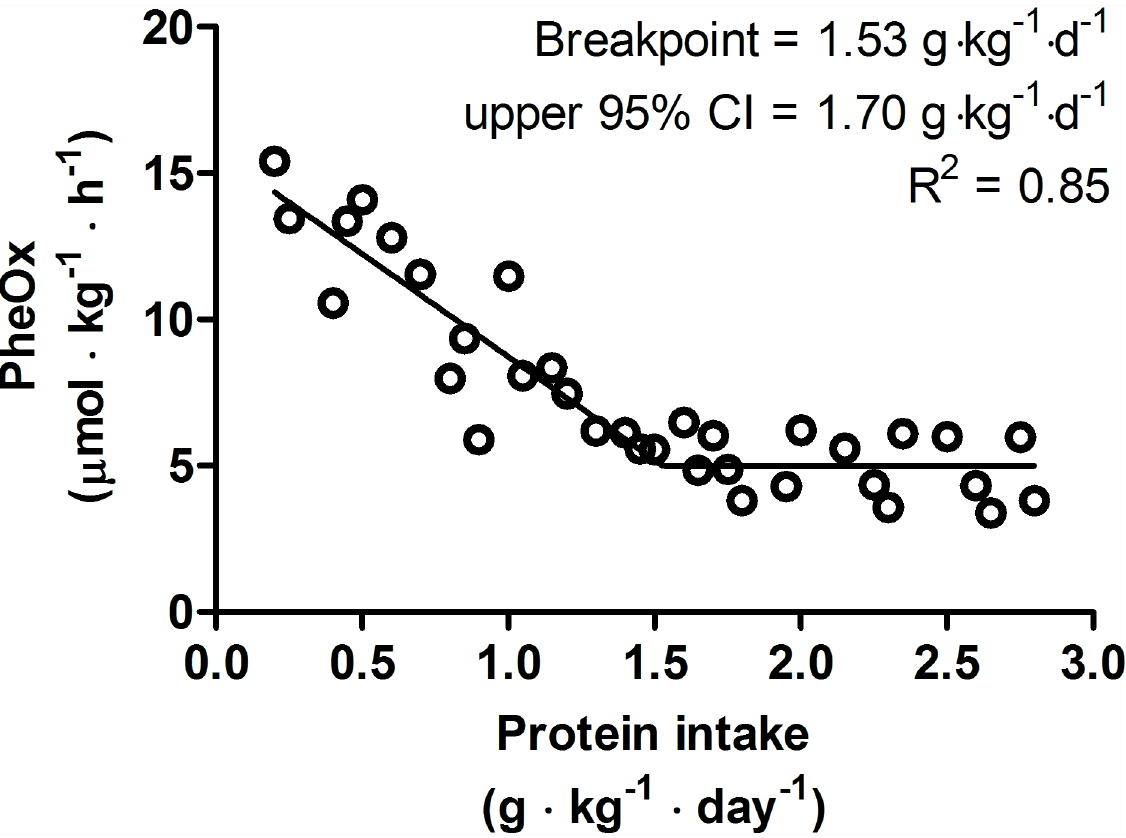
Fig 4. Relationship between protein intake and PheOx. 6 participants completed 34 metabolic trials with a range of test protein intake (0.2 – 2.8 g (cid:1) kg -1 (cid:1) d -1 ). The breakpoint estimated the average protein requirement. The breakpoint was determined by using a biphasic linear regression crossover analysis. The average protein requirement and recommended protein intake were estimated to be 1.53, 1.70 g (cid:1) kg -1 (cid:1) d -1 respectively (R 2 = 0.85).